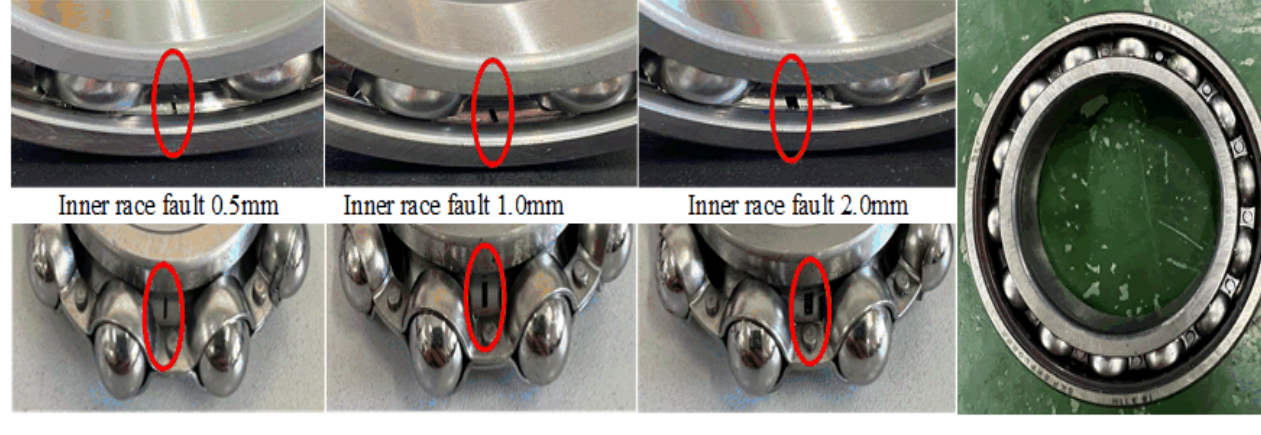
Figure 9. Pictures of faulty bearings .